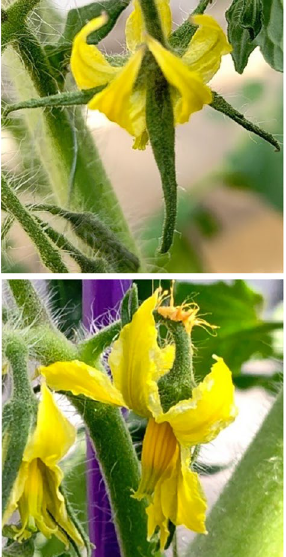
Figure 12. Examples of ambiguous flower